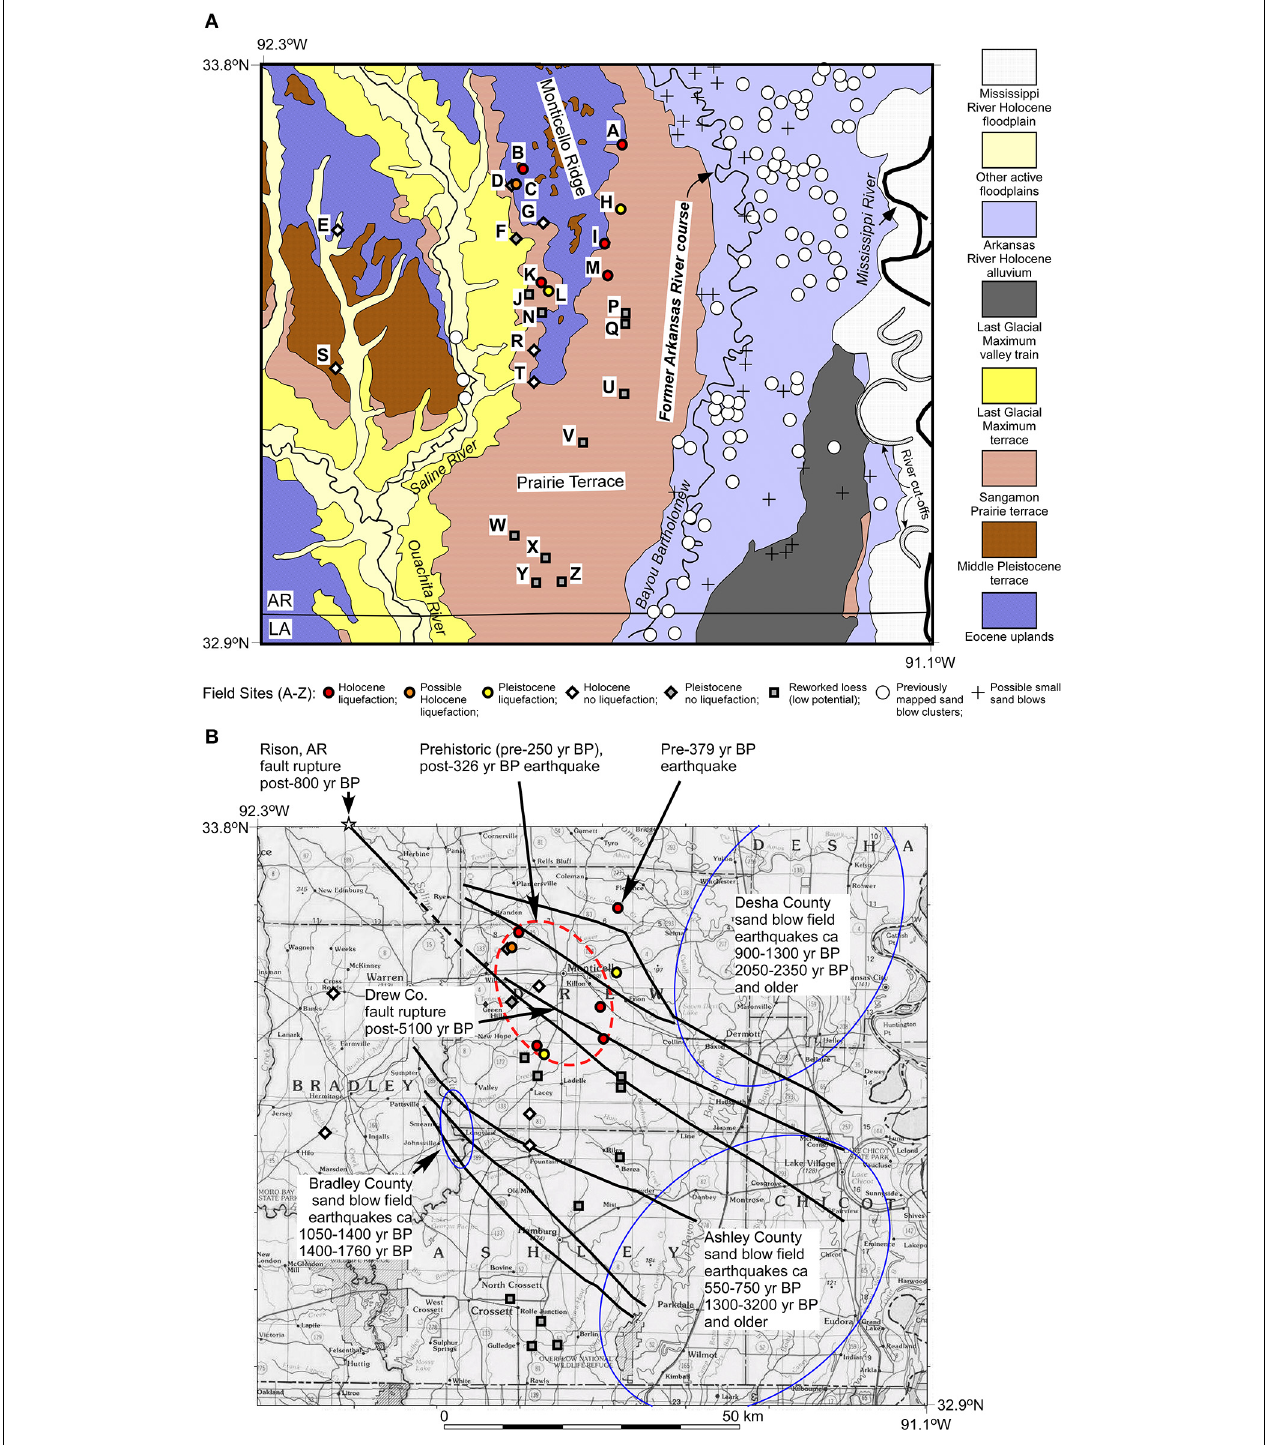
FIGURE 2 | (A) Geologic map of study area showing previously reported sand blow sites (Cox et al., 2004, 2007, 2010) and the 25 labeled field sites in this study ( Table 1 ). A “Site O” designation was intentionally not used to avoid confusion with Holocene liquefaction sites. Geology compiled from Onellion